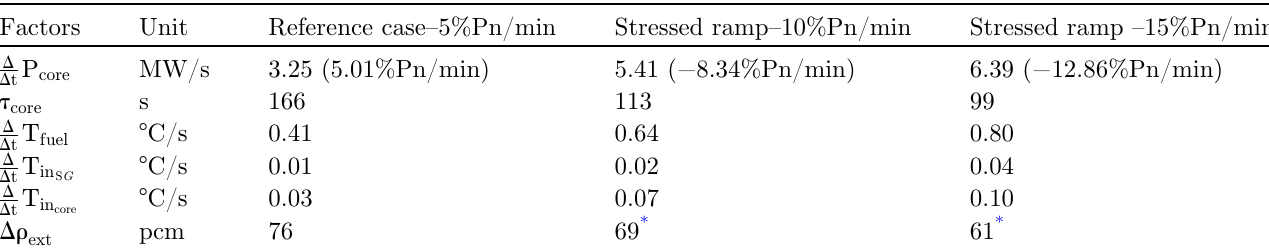
Table 4. Comparison of indicators for two constrained transients with a magnitude of 10%Pn. Factors